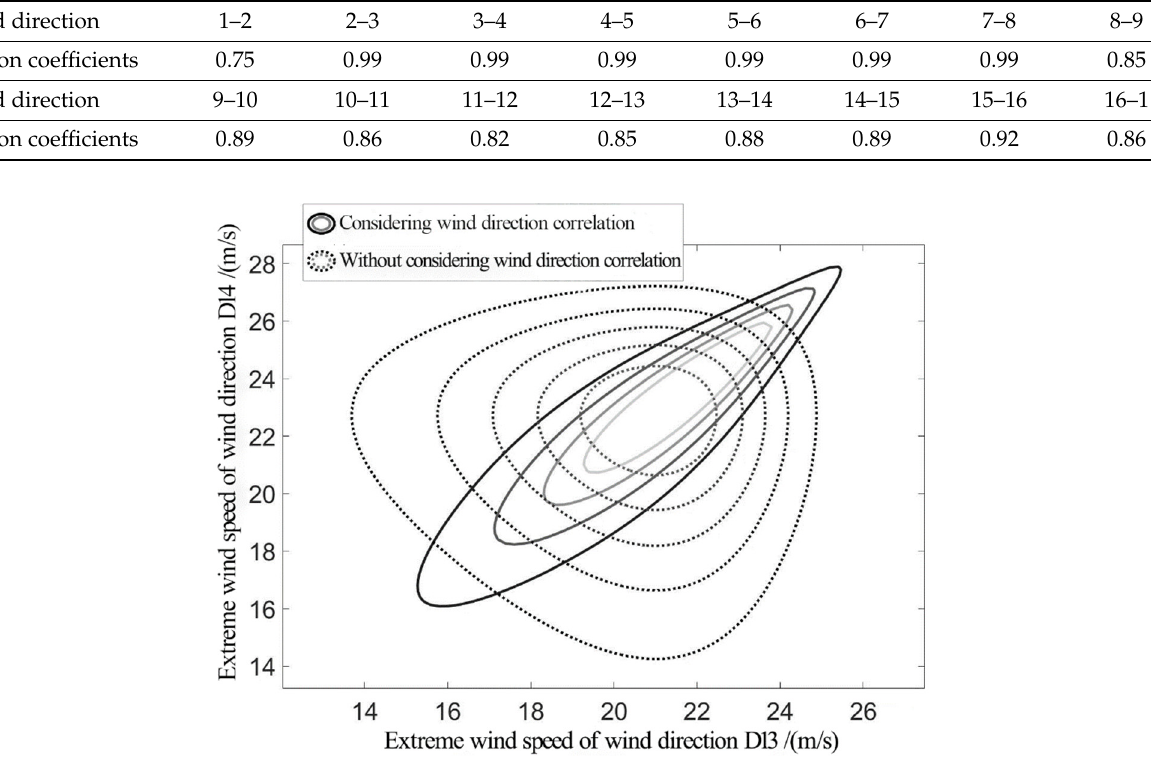
Figure 14. The joint probability density contours of the typhoons under wind directions D13 and D14.